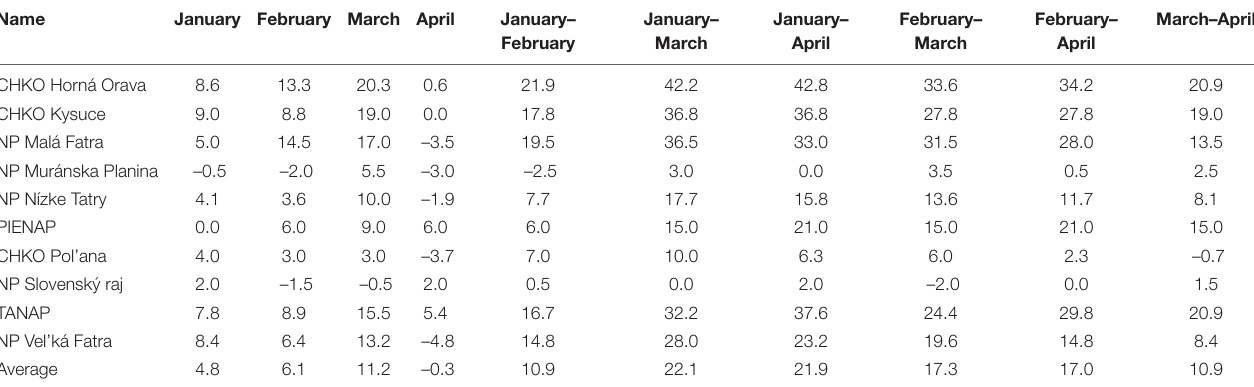
TABLE 6 | Difference of monthly total precipitation (in mm) in protected areas between the monitored